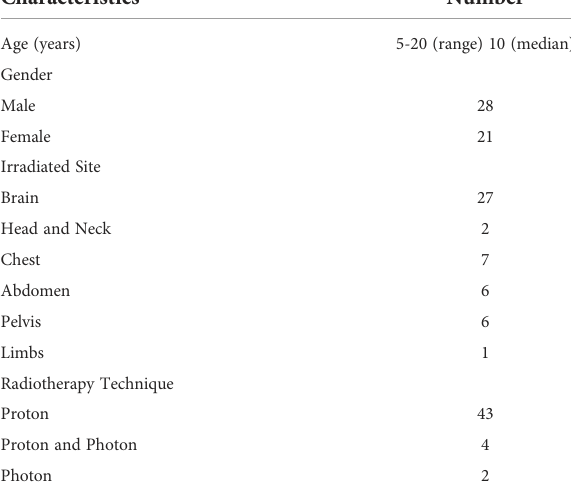
TABLE 1 Patient